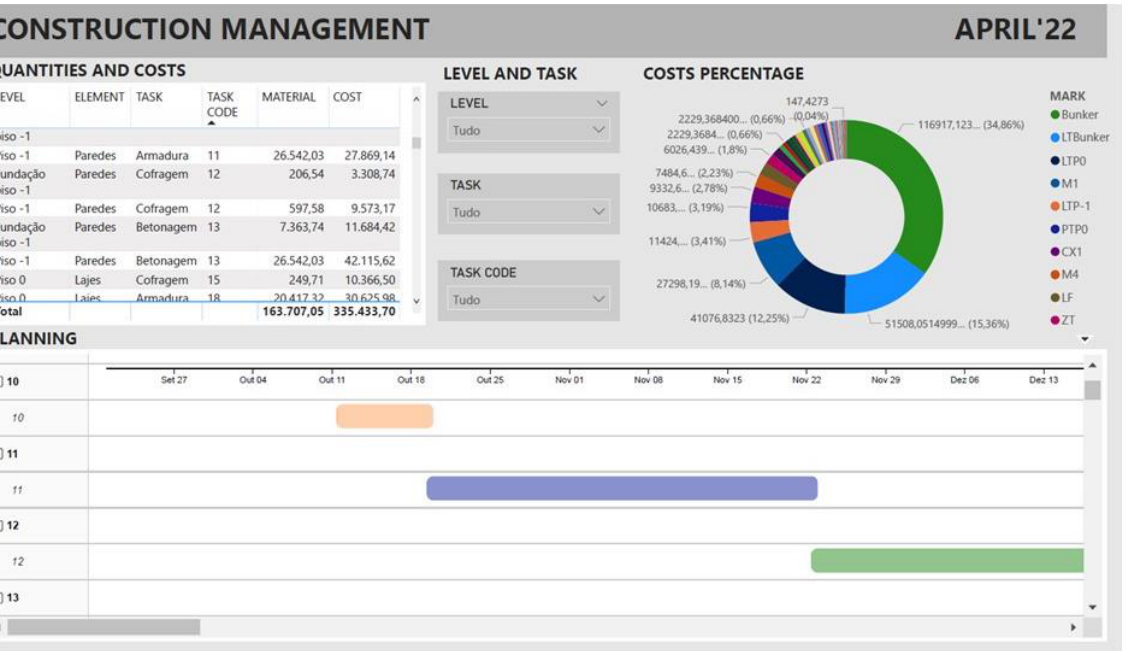
Figure 9. Power BI dashboards—Level 0—pouring concrete task.